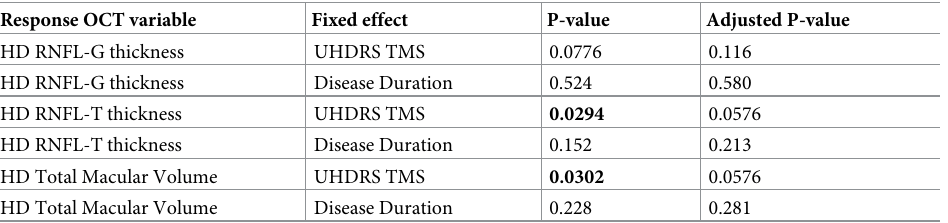
Table 4. Linear mixed effects models for RNFL-G thickness, RNFL-T thickness, and macular volume in the Hun- tington’s disease group with UHDR TMS and disease duration as fixed